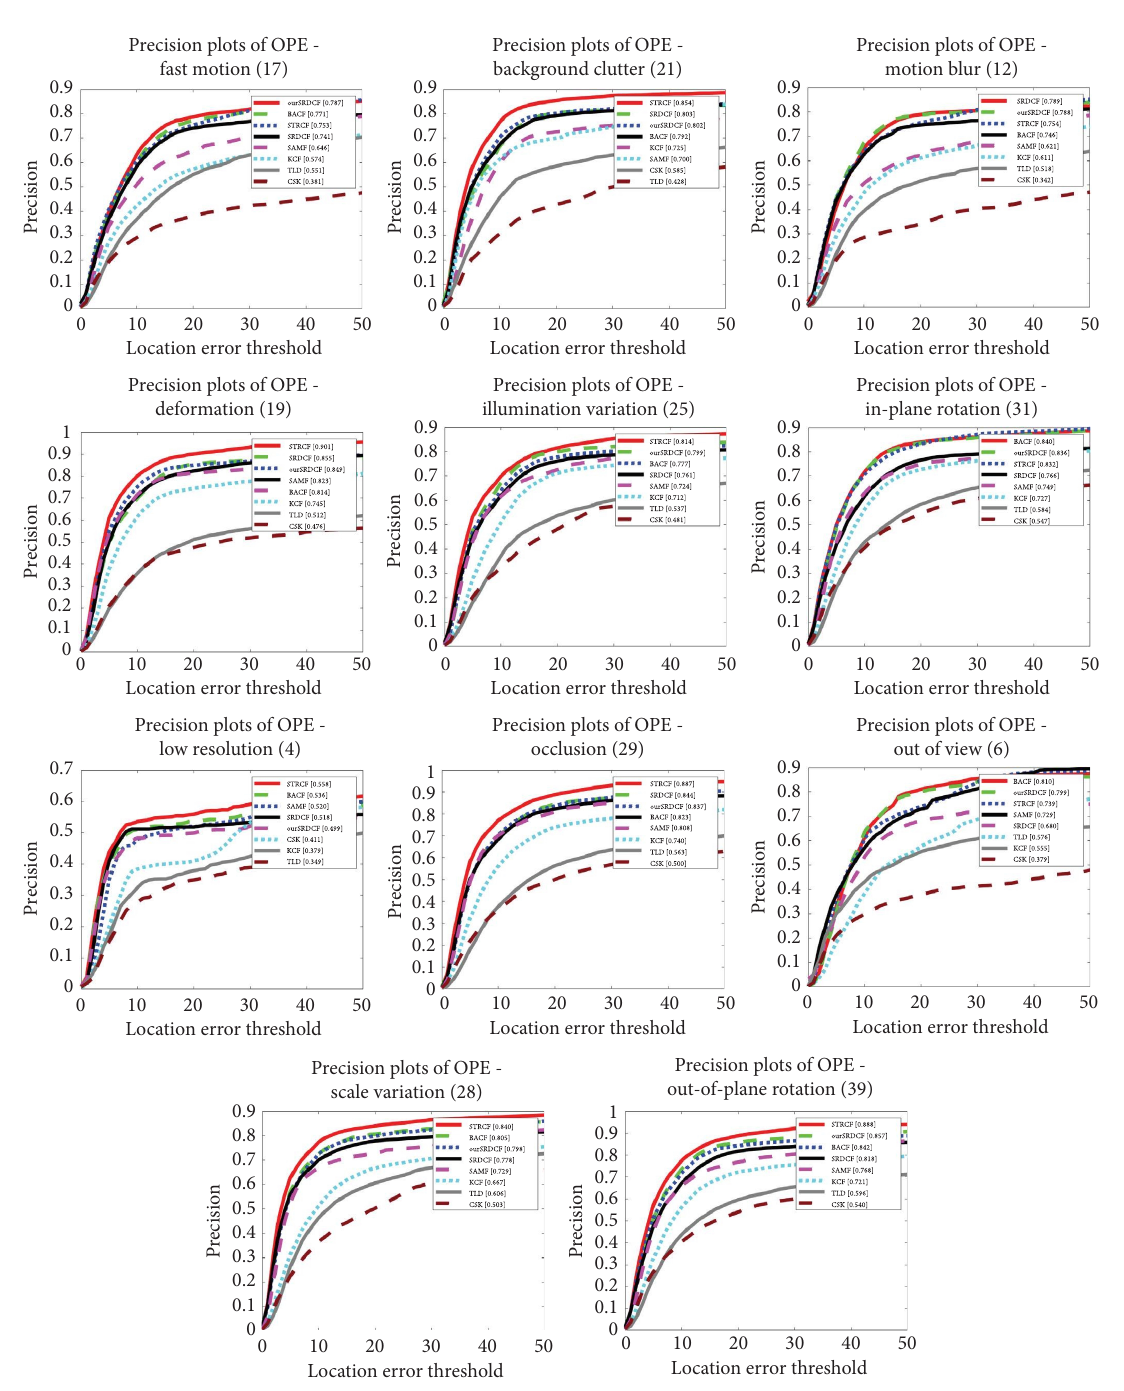
Figure 5: Te accuracy curves of the six algorithms on the OTB-2015